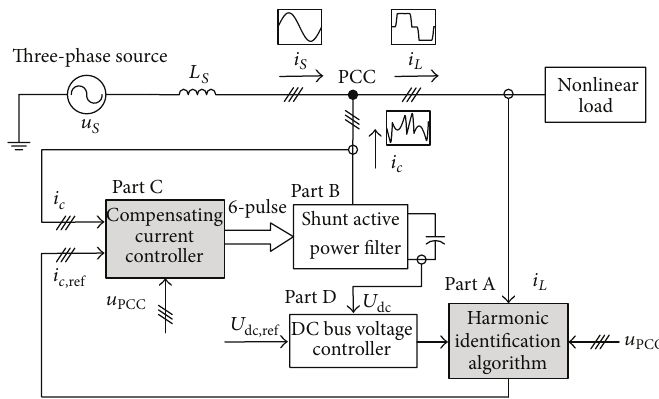
Figure 1: The harmonic elimination system via shunt active power